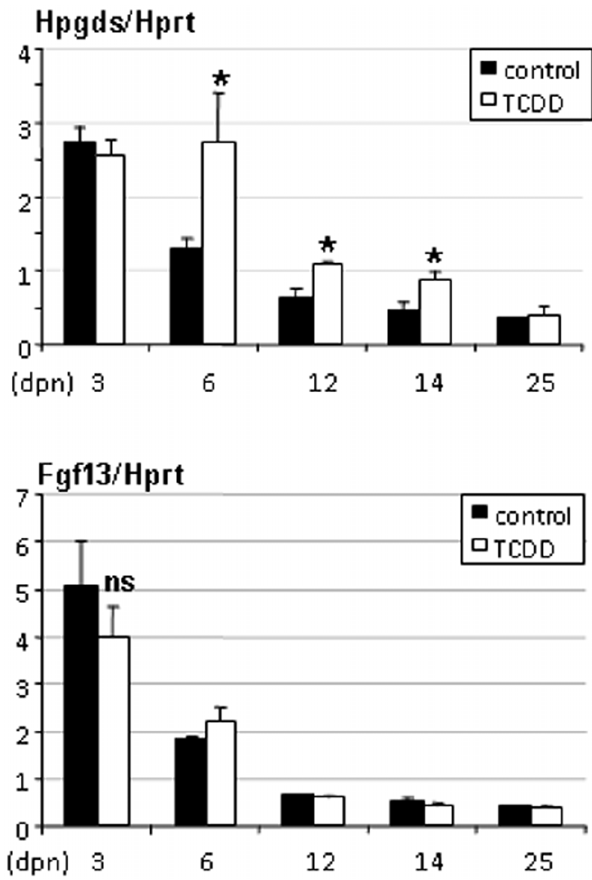
Figure 5. Hpgds and Fgf13 gene expression levels in ovaries of rats exposed in utero to TCDD. Ovaries were recovered from females of 3 to 25 days of age. Levels were normalized using Hprt. Values are the mean 6 SEM of of n=4 to 6 animals (n=2 for 3- and 25- day control ovaries). *p , 0.05 versus its time-matched control. (dpn), days